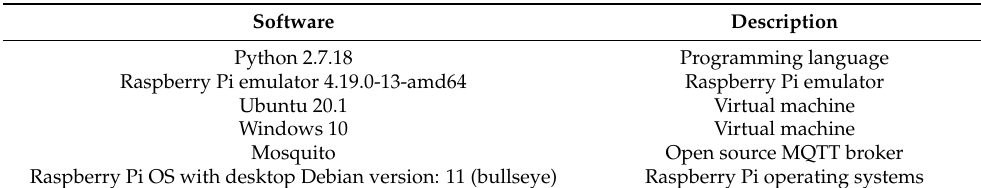
Table 3. Software versions deployed in performance evaluation.